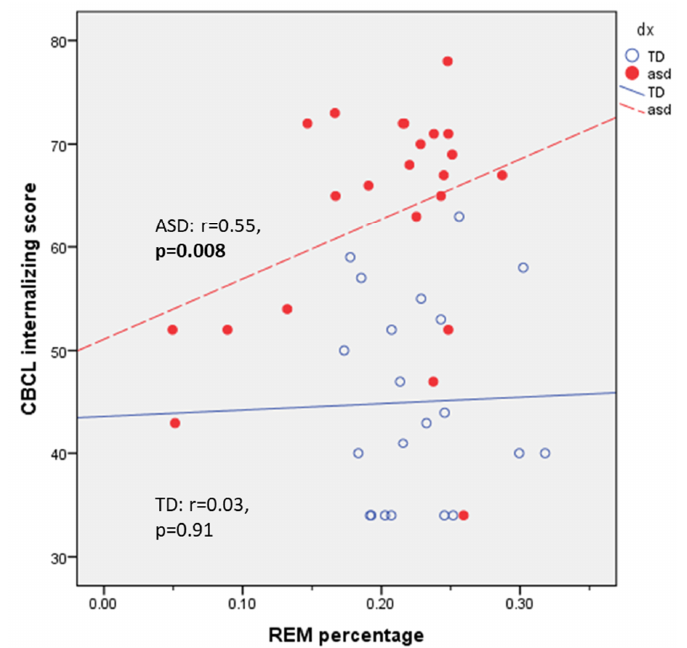
Figure 1. REM sleep percentage correlates with Child Behavior Checklist internalizing (CBCLi) score in ASD group but not TD. Bolded p -values represent significance p < 0.05. Table 3. Associations between REM and NREM Sleep and CBCL Scores within